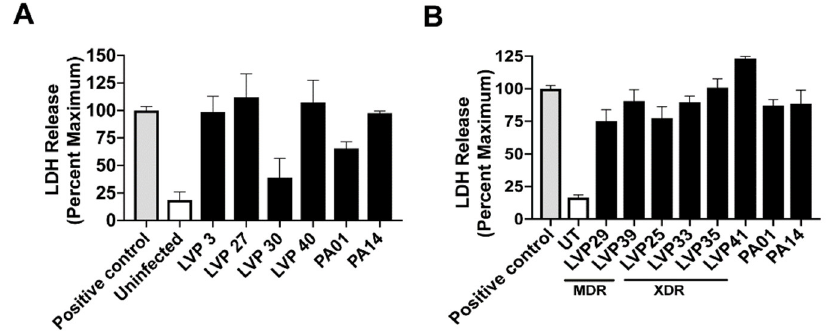
Figure 3. Cytotoxicity of human corneal epithelial cells by clinical isolates of P. aeruginosa . Cells were infected with the clinical isolates harboring different exotoxins, LVP3 ( exoS +/ exoU −), LVP27 ( exoS −/ exoU +), LVP30 ( exoS −/ exoU −) and LVP40 ( exoS +/ exoU +) ( A ) or drug-resistant isolates ( B ) for 6h and cytotoxicity was measured by release of LDH into the culture media compared to lysed cells (positive control). The error bars represent three technical replicates and the experiments have been repeated three times. UT represents untreated cells.